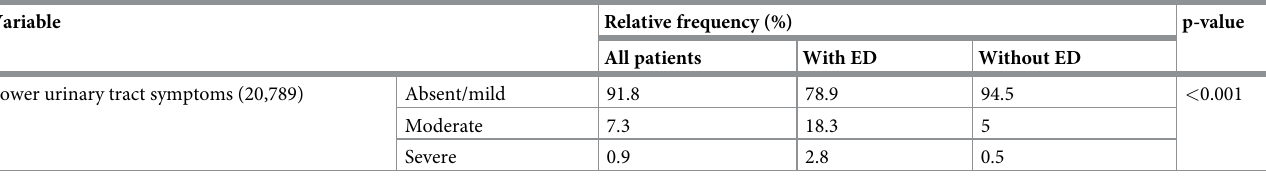
Table 3. Relative frequencies (%) of urological comorbidities in relation to ED (n = 20,789). Variable